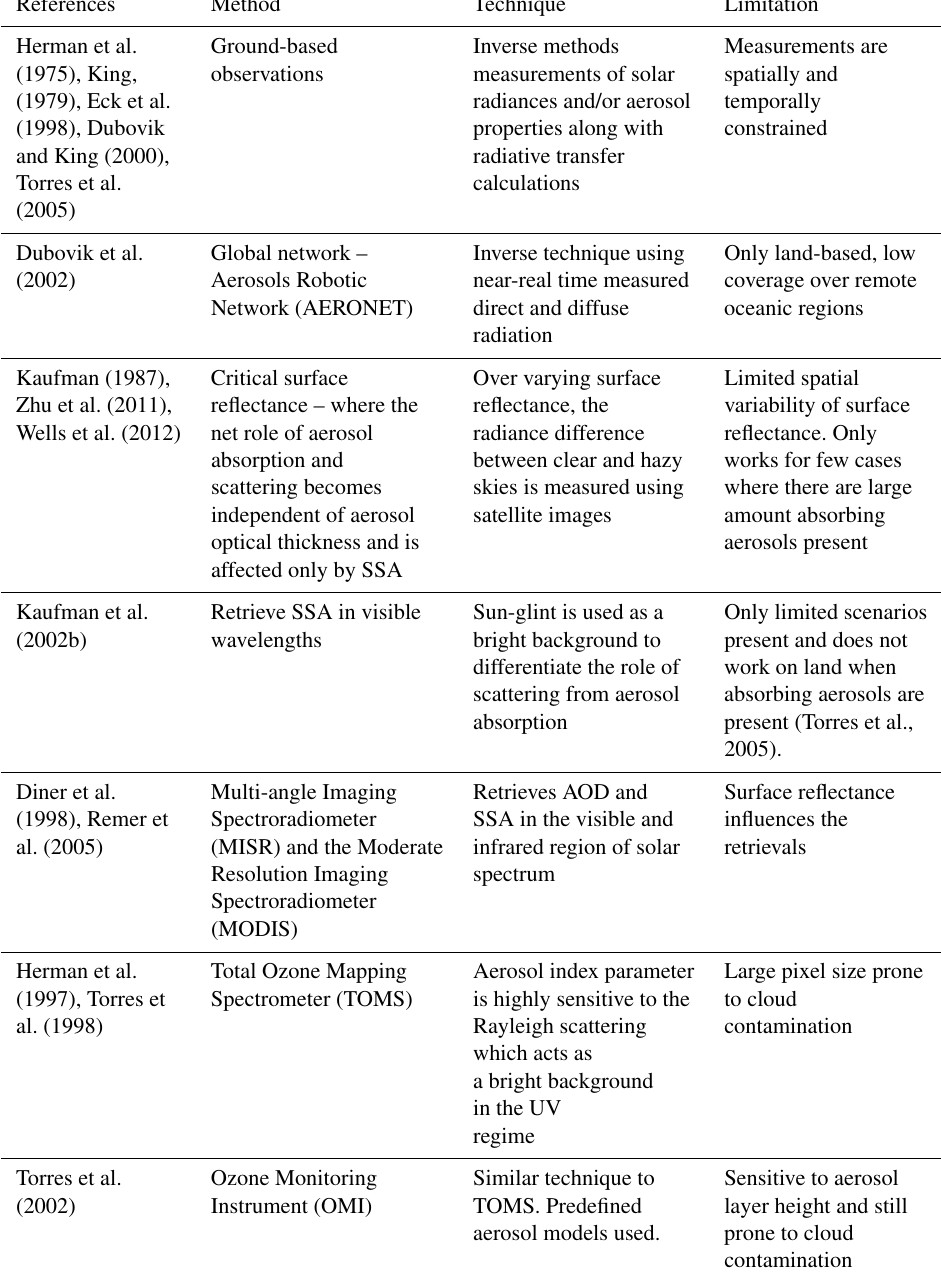
Table 1. Ground-based and satellite-based indirect methods of retrieving